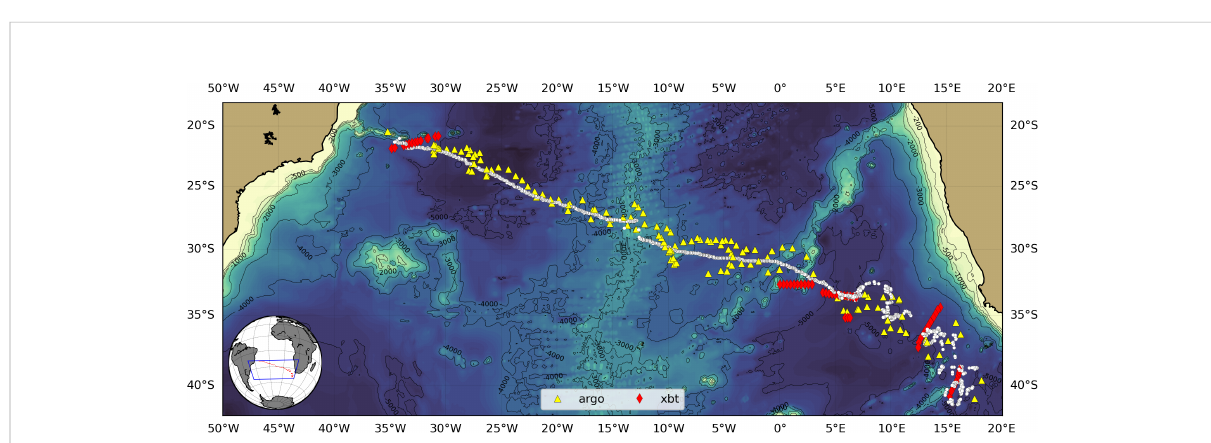
FIGURE 12 The path of the Ring Jeannette between 28-Jan-2012 and 27-Dec-2015. Besides the Argo pro fi les distributed along its route through the Atlantic, two XBT sections crossed the ring, one in the Cape Basin and the other next to the Brazilian coast. The bottom topography is shown in the background.